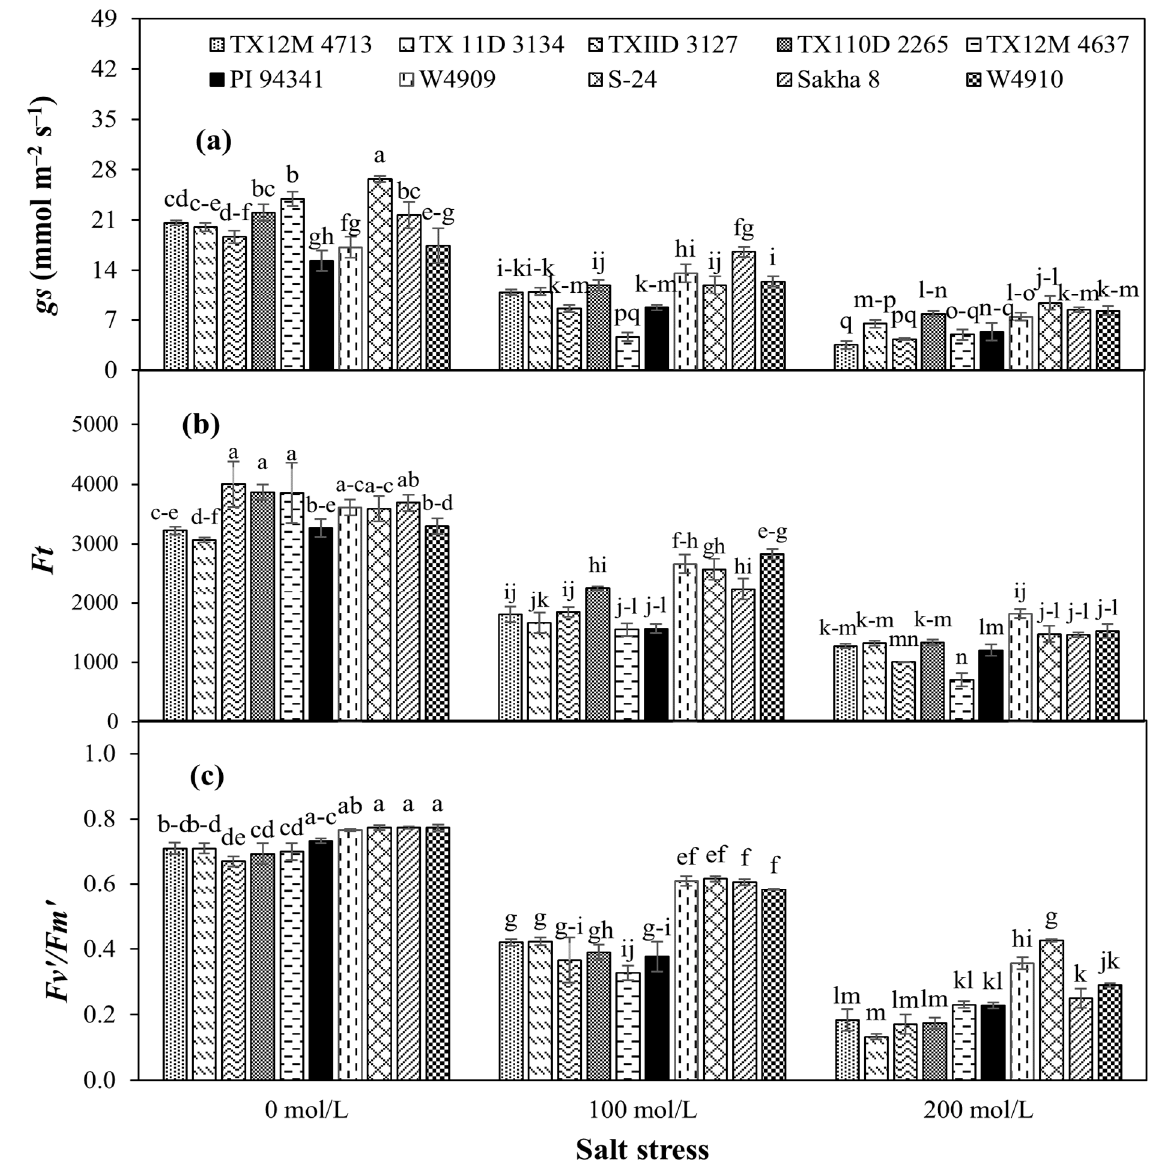
Figure 5. Influence of salt stress on ( a ) stomatal conductance ( gs ), ( b ) efficiency of photosystem II (PSII), and ( c ) maximum quantum yield of photosystem II ( Fv ′ /Fm ′ ) of wheat genotypes. Error bars indicate S.E. ( n = 3 ). Different letters above the bars represent significant differences at the p < 0.05.